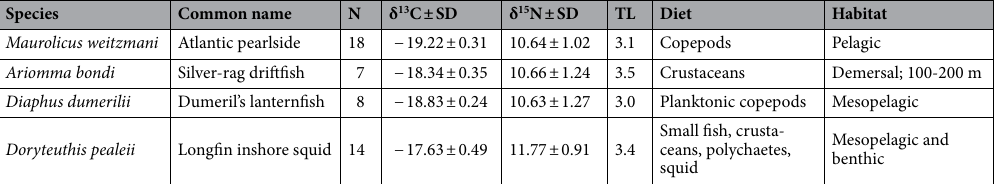
Table 2. Potential prey used in the mixing model to determine prey preferences of Rice’s whale ( Balaenoptera ricei ), including sample size (N), mean (± SD) stable carbon and nitrogen isotope values (i.e., δ 13 C and δ 15 N), trophic level (TL), diet, and habitat. TL, diet, and habitat taken from Fishbase and Sealifebase.